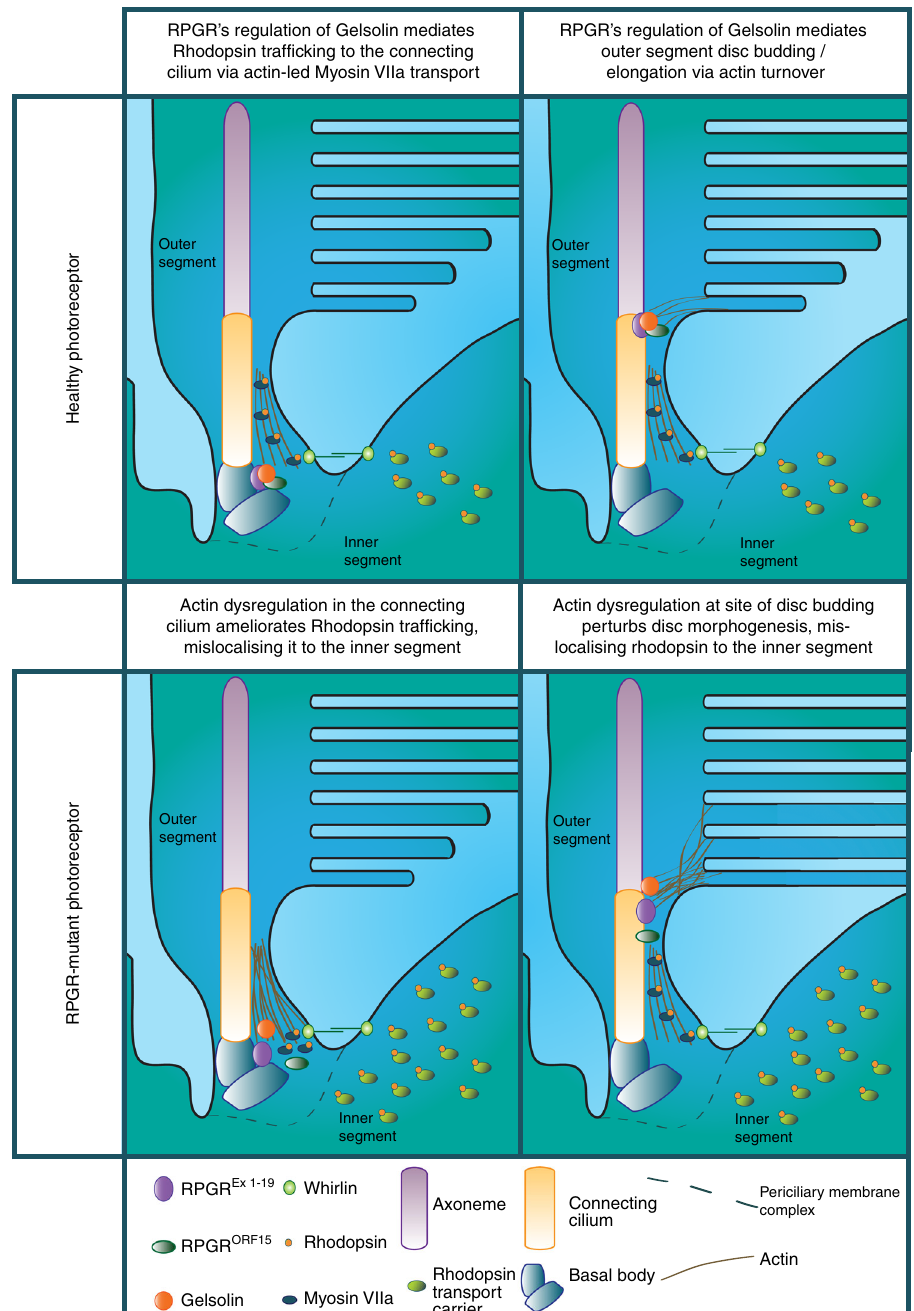
Fig. 7 Proposed model for RPGR mediated actin turnover in the photoreceptor connecting cilium. We propose two possible mechanisms of action for RPGR. First, RPGR ’ s regulation of actin turnover could mediate rhodopsin traf fi cking into the photoreceptor connecting cilium ( left panels). An actin bundle connects the periciliary membrane complex to the basal body, along which Myosin VIIa actively transports visual pigments. Whirlin regulates this actin network at the connecting cilium base and interacts with both gelsolin and RPGR, suggesting a model whereby mutant RPGR disrupts the complex, perturbing actin turnover and compromising Myosin VIIa-mediated rhodopsin transport ( left panels). The resulting rhodopsin mislocalisation to the inner segment results in cell stress and degeneration. Second, RPGR ’ s regulation of actin turnover could facilitate outer segment disc formation ( right panels). Actin exerts an in fl uence on both ciliogenesis and maintenance and is localised to the site of photoreceptor disc budding. The disorganised discs and hyperstabilised actin seen in the Rpgr knockout mouse supports a model whereby RPGR facilitates outer segment disc budding or the completion of disc formation by gelsolin-mediated actin turnover ( right panels). The compromised disc morphogenesis seen with mutant RPGR would mislocalise rhodopsin to the inner segment, resulting in cell stress and